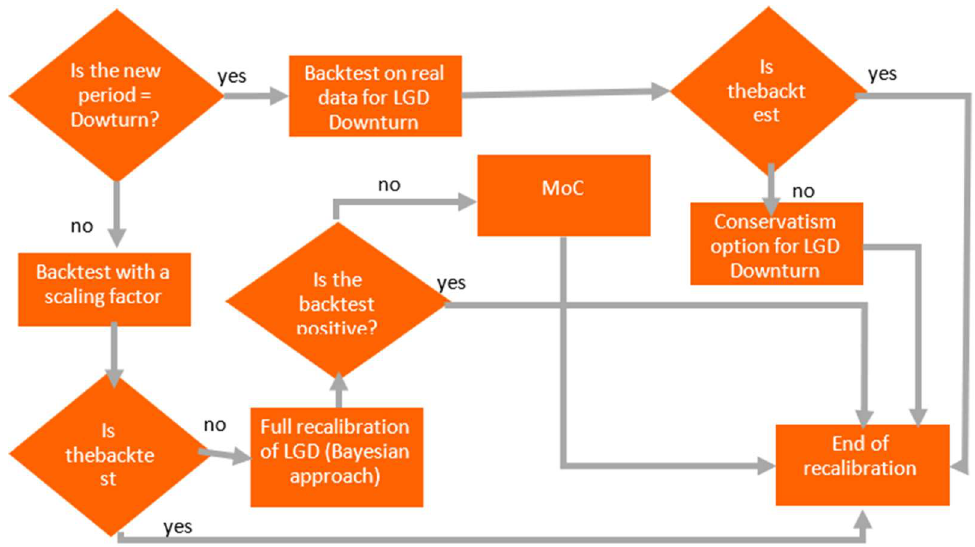
Figure 3. LGD model recalibration scheme. Source: own elaboration.